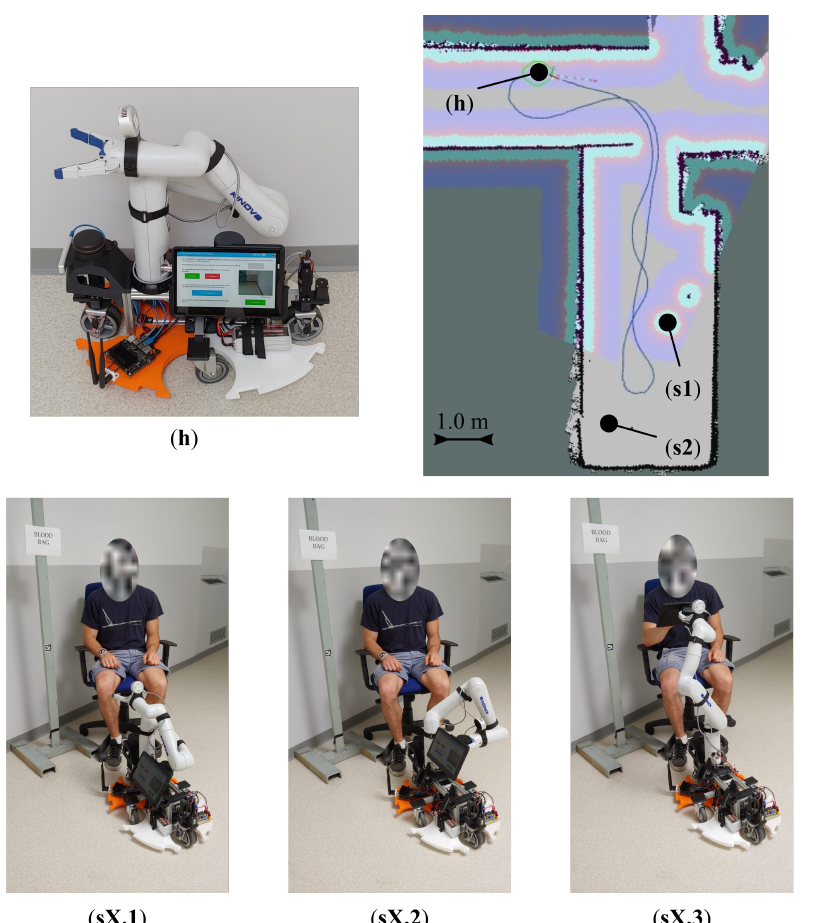
Figure 7. HMI developed for the experimental test.